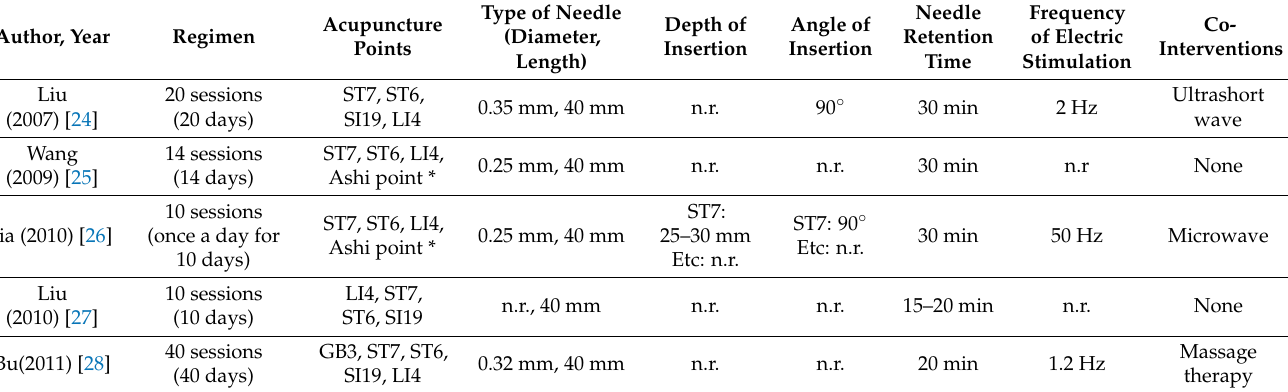
Table 2. Characteristics of electroacupuncture interventions in the included